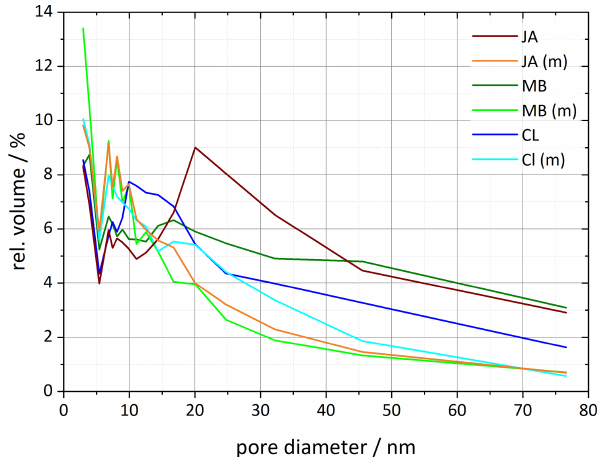
Figure 8. Pore size distributions for selected halloysite samples and their corresponding milled samples resulting from DVS isotherms analyzed between 35% and 98% RH (calculated using Eq. 1 in Sect. 3.3). Dust sample codes are identical to those in Fig.